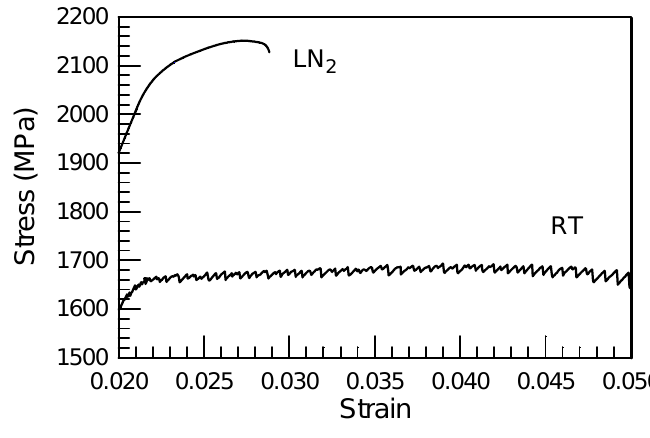
Ni Cu Al glassy alloy tested at 64.13 10.12 15.75 10